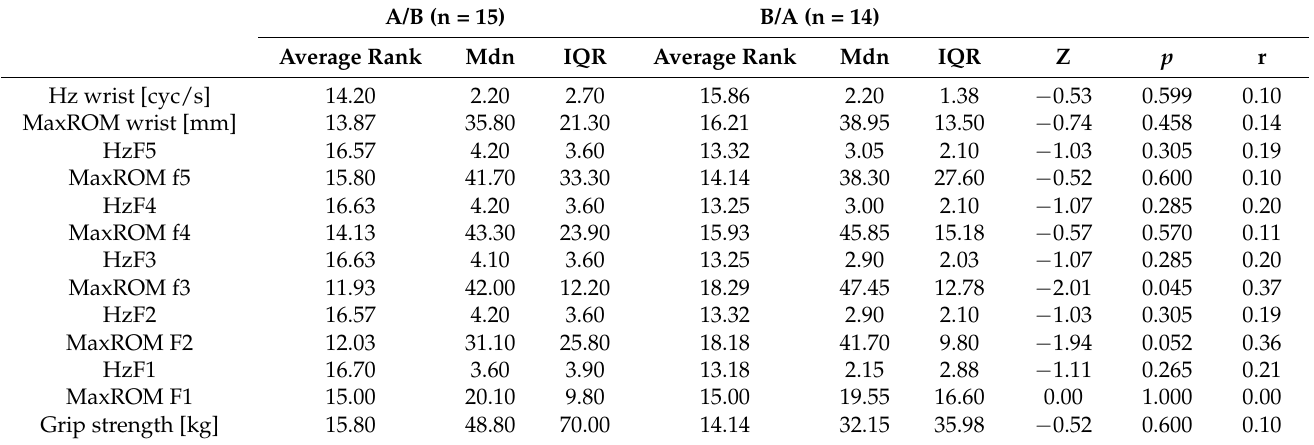
Table 3. Comparison of groups in terms of sum of parameters from the first and second measurement without stabilization.